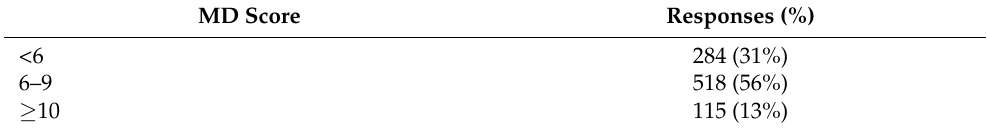
Table 2. Mediterranean diet adherence score for 917 Arabic-speaking female